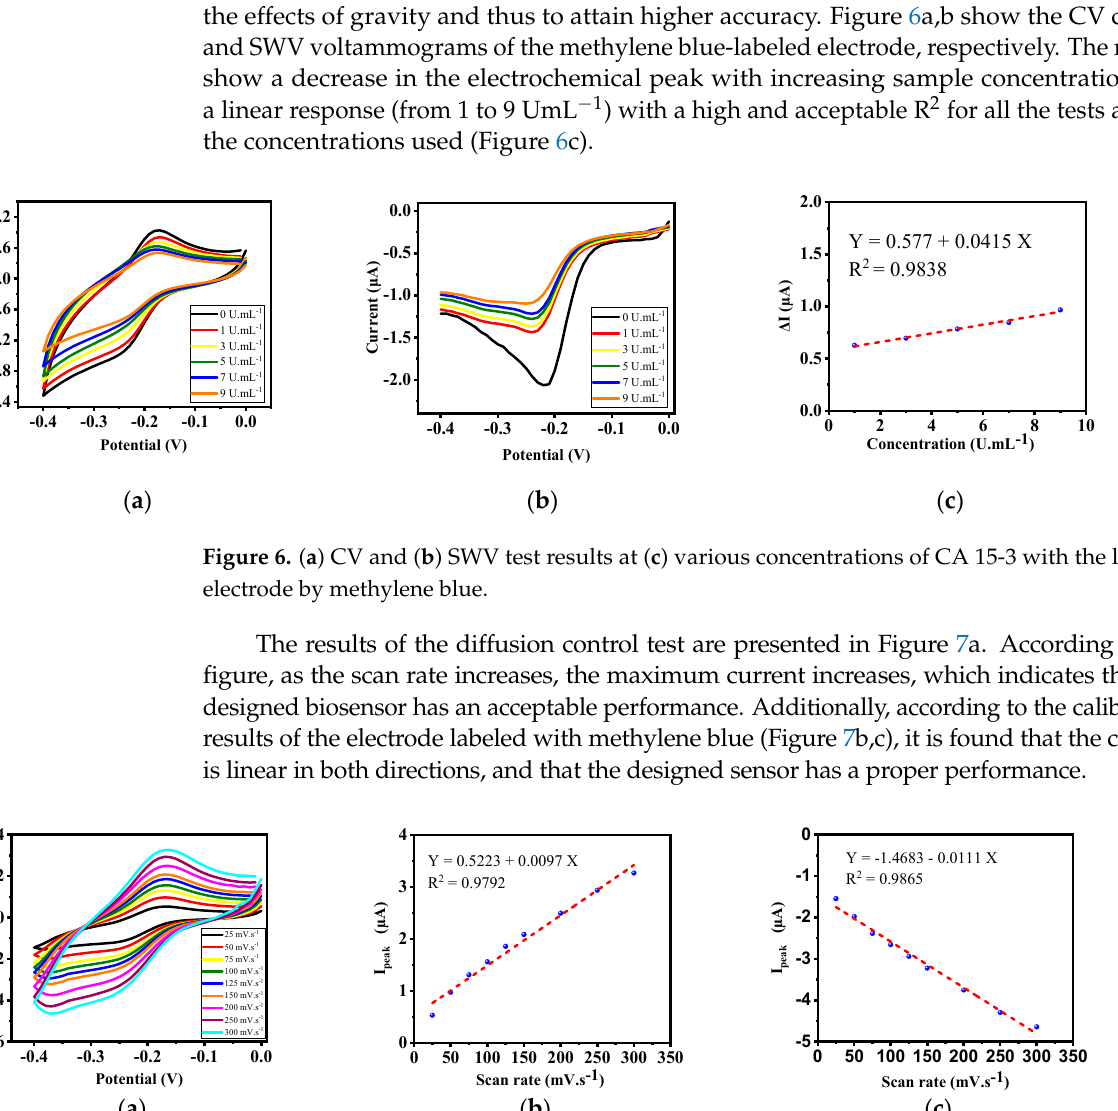
Figure 5. ( a ) CV analysis, ( b ) SWV voltammograms, and ( c ) Nyquist diagrams of the electrode in